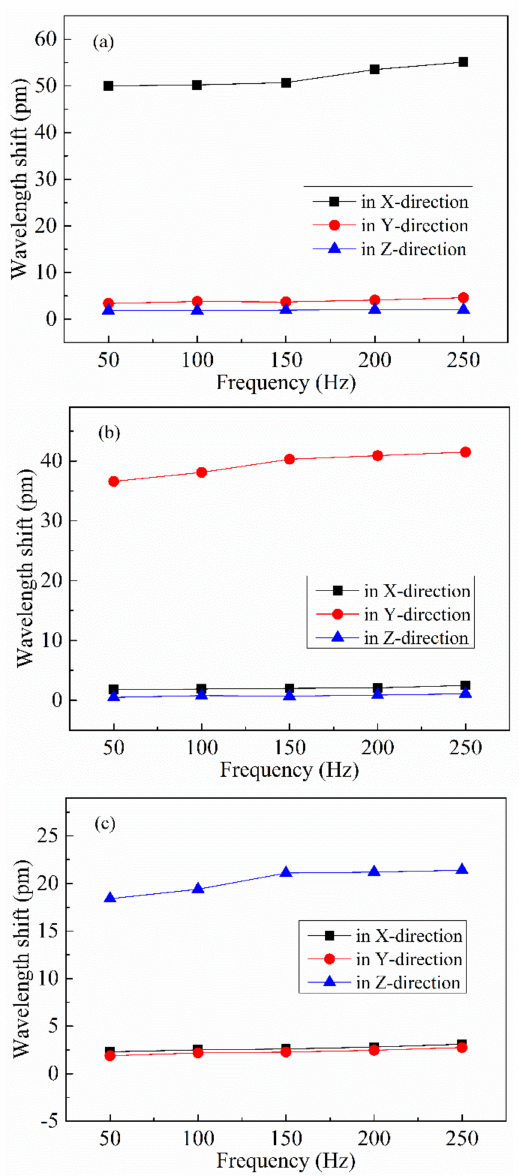
Figure 21. Wavelength shift versus frequency curves of accelerometer in the x-direction ( a ), y- direction ( b ), and z-direction ( c